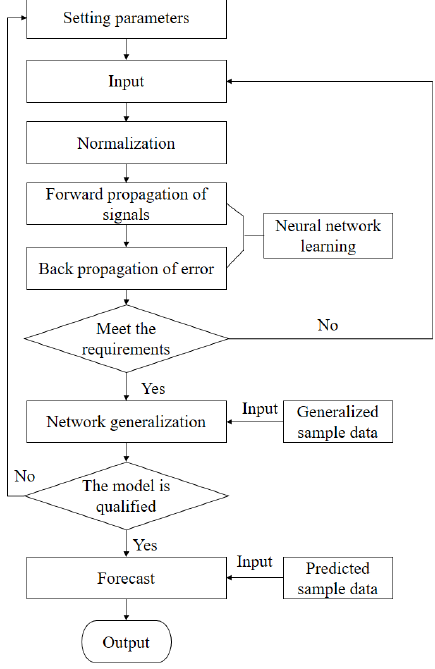
Figure 3. Flowchart of the LM-BP neural network